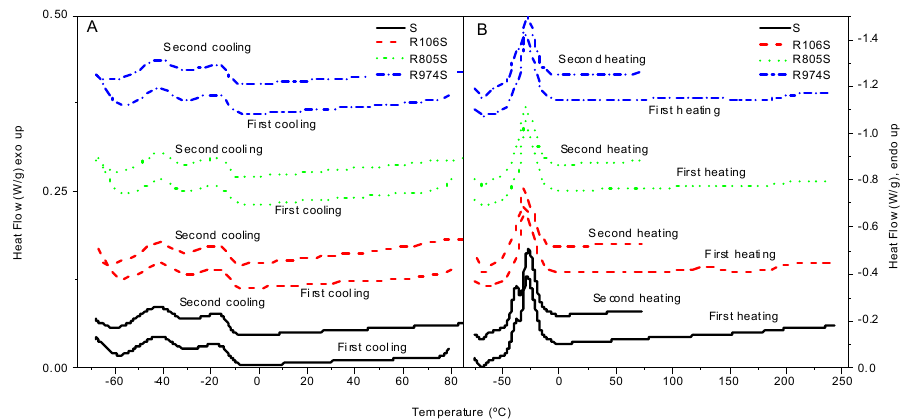
Figure 3. MDSC thermograms for HFS suspensions studied. ( A ) Cooling curves. ( B ) Heating curves. Table 4. MDSC thermal events from the cooling and heating cycles of the samples studied.